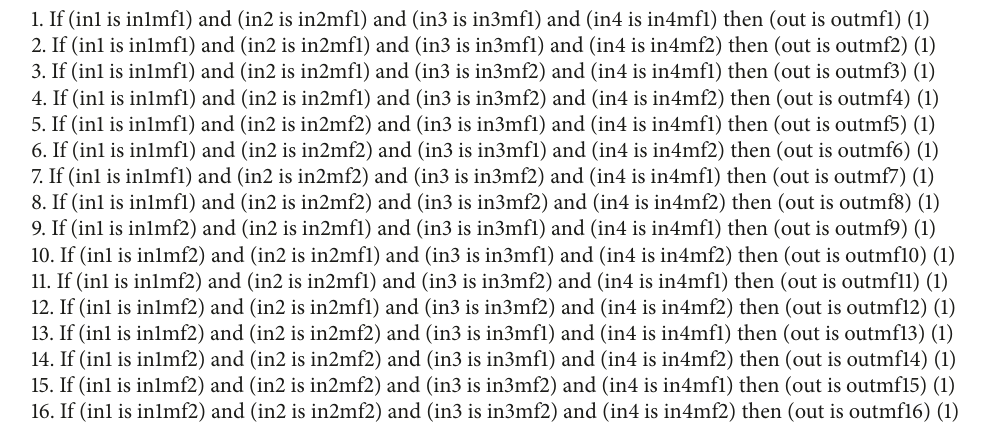
Box 1: Fuzzy rules for the ball and beam